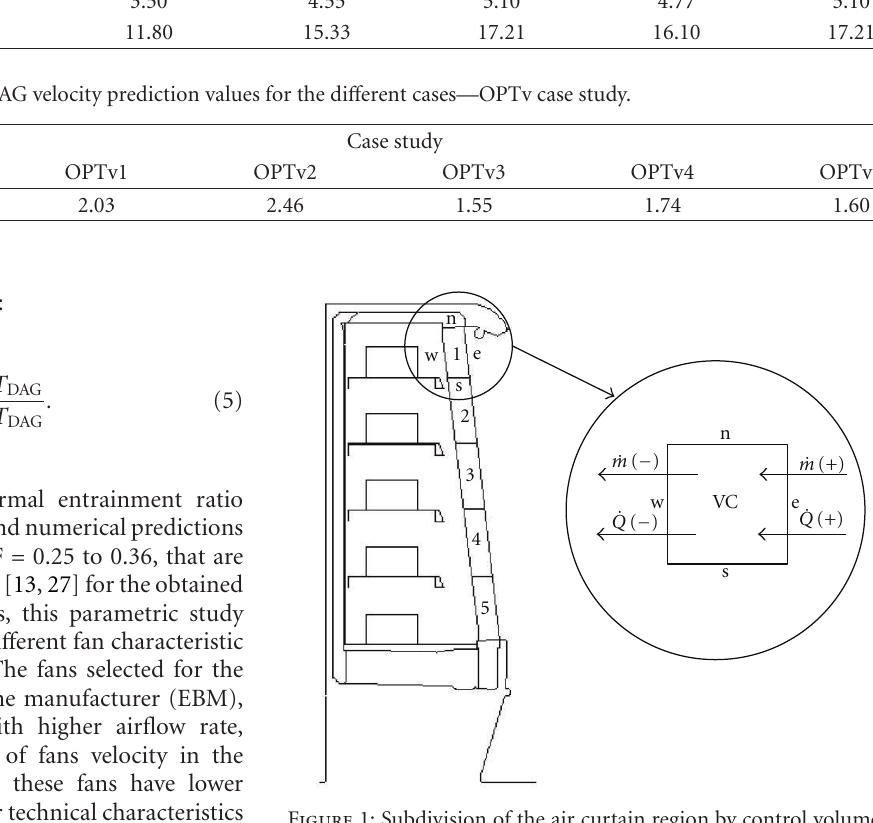
Figure 1: Subdivision of the air curtain region by control volumes and sign convention of the